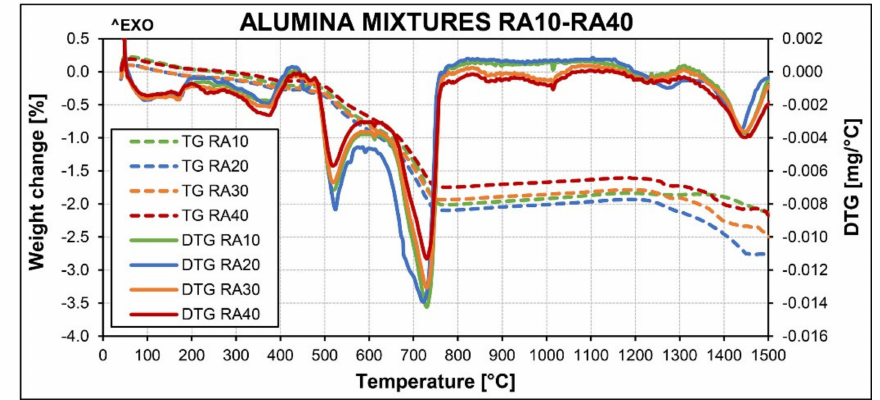
Figure 7. Thermal analyses of mixtures with reactive alumina